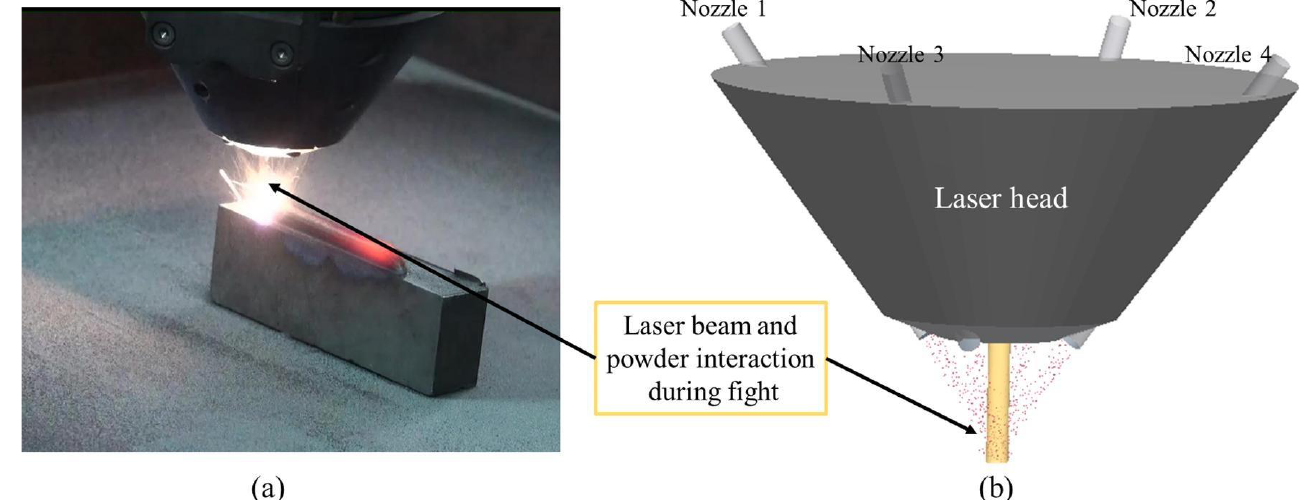
Figure 2. Direct energy deposition process ( a ) experimental setup and ( b ) schematic [19]; with permission from Elsevier.